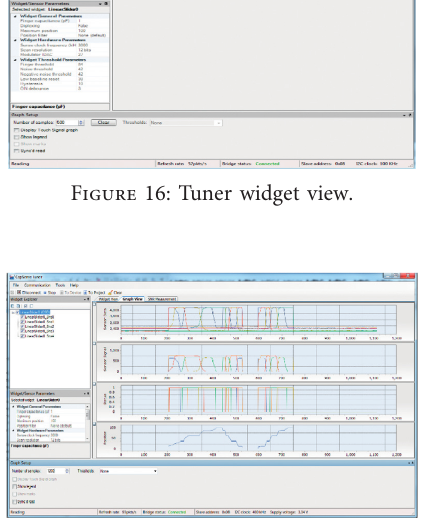
Figure 17: Tuner graph